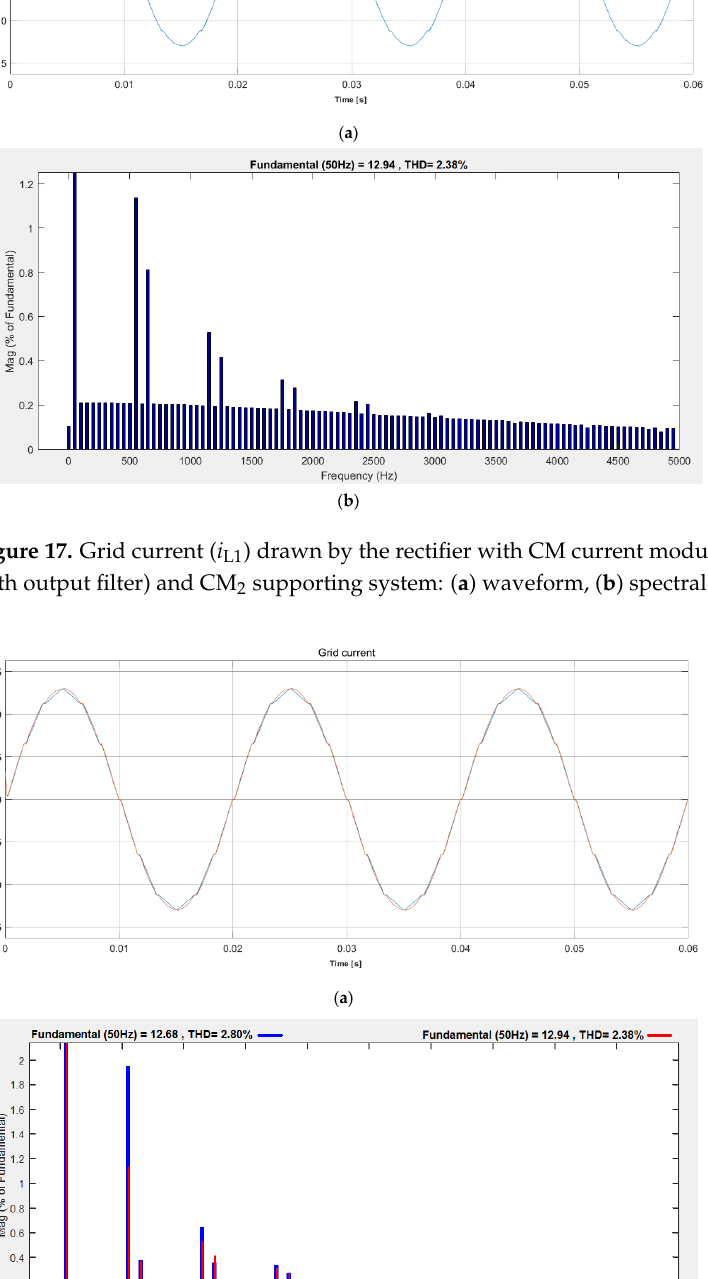
Figure 18. Comparison of: ( a ) grid current ( i L1 ) waveform for the case of the diode rectifier with the CM current modulator based on the transistor H-bridge and on (red) and off (blue) CM 2 supporting system, ( b ) spectral analysis.